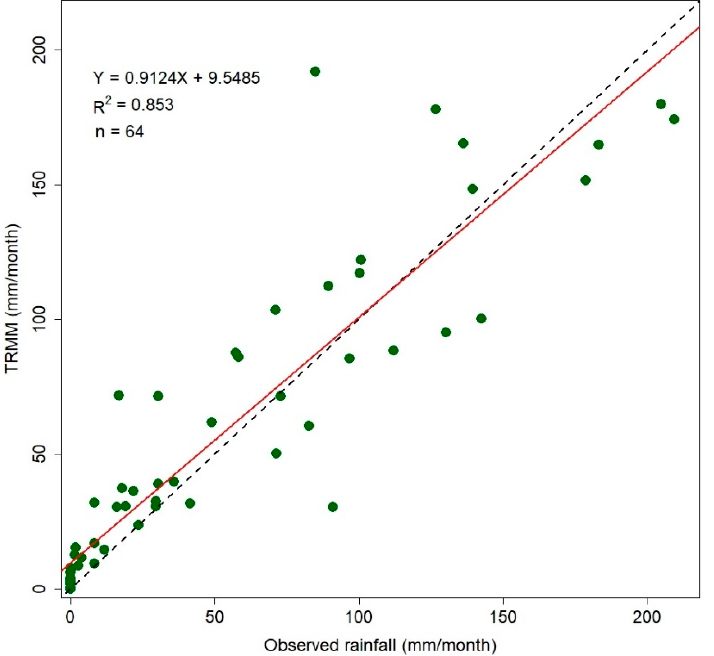
Figure 3. Linear relationship between precipitation data collected at the meteorological station of Zakho and the corresponding cell of the TRMM data for the period September 2002–December 2007 [48]. Table 2. Classes of soil structure derived from the European Soil Database.